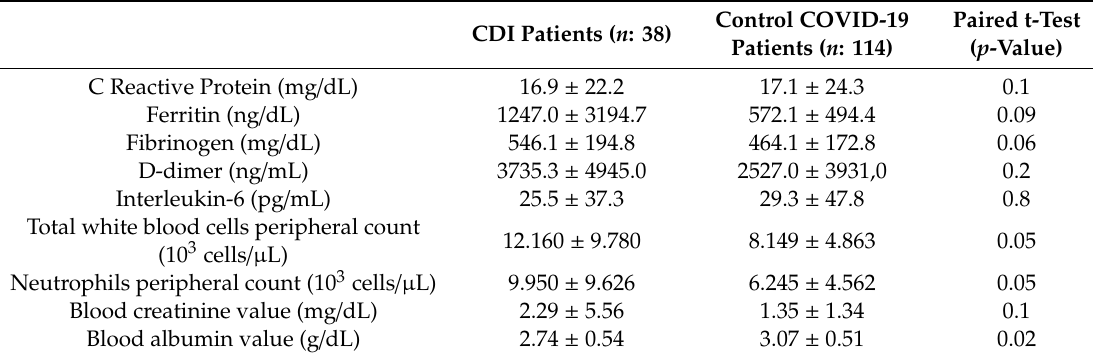
Table 2. Mean laboratory findings at the admission of the 38 COVID-19 patients with CDI cases and of the 114 controls included in the study. Ns: not significant.